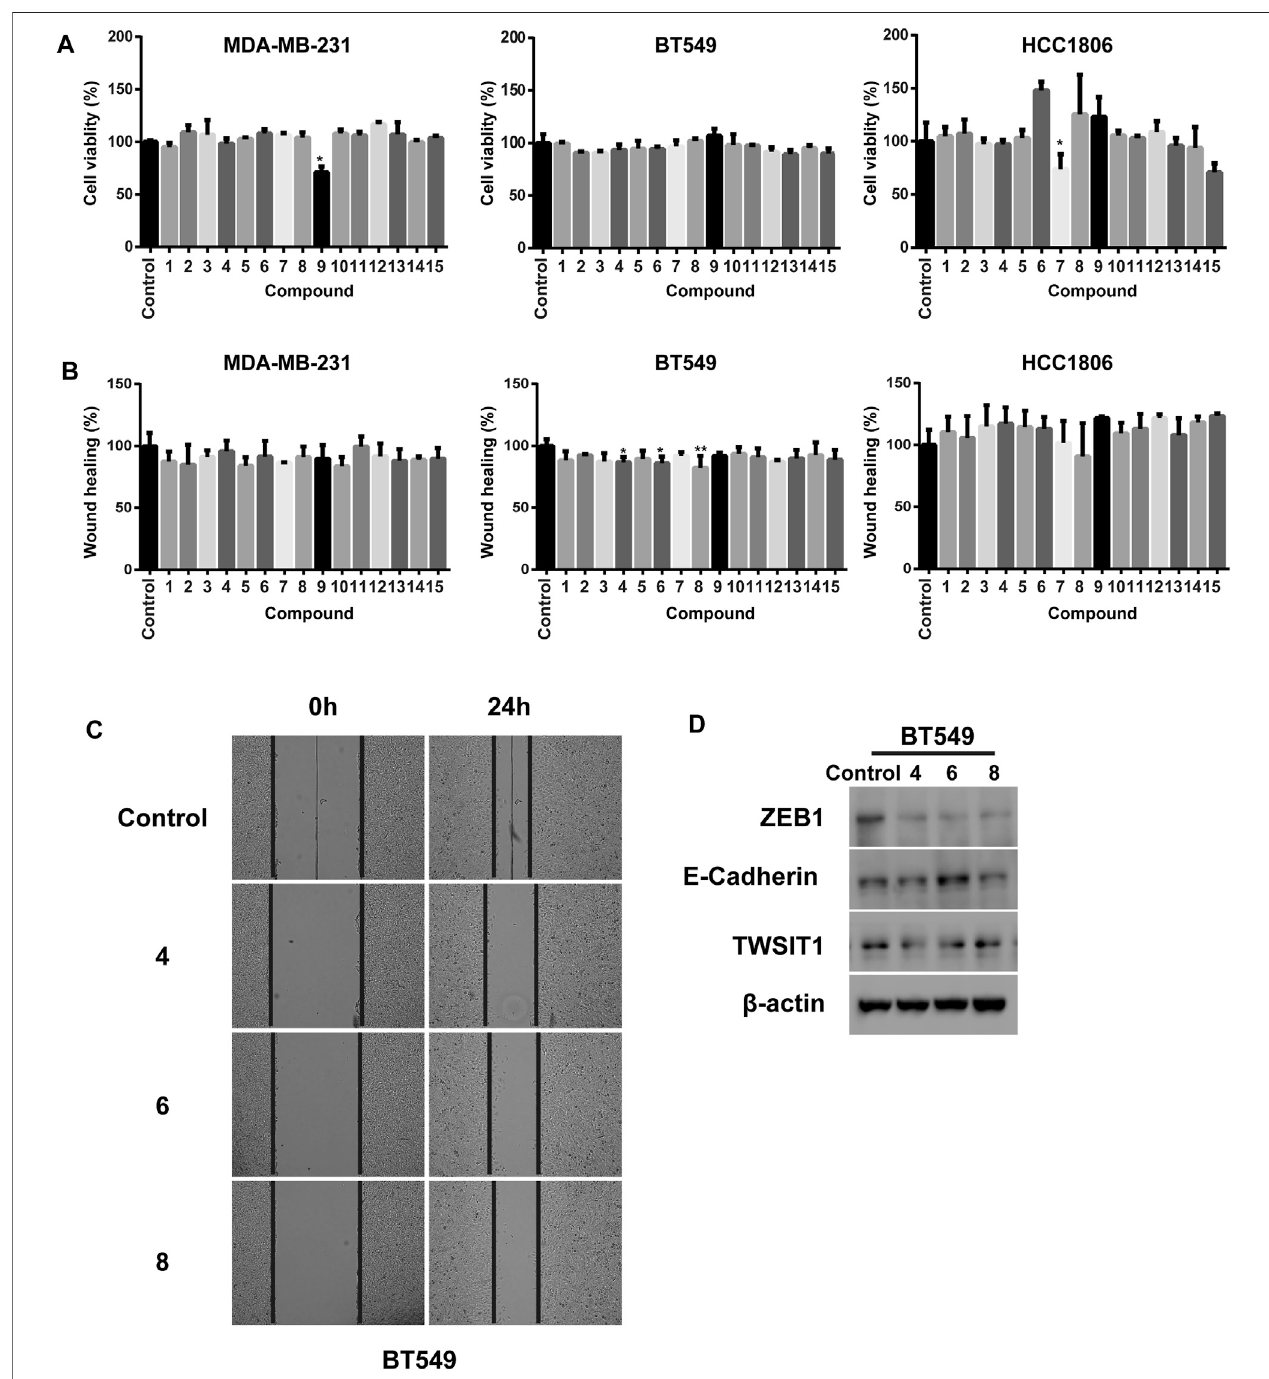
FIGURE 7 | (A) Cell viabilities of MDA-MB-231, BT549 and HCC1806 were analyzed by using CCK8. All compounds concentrations were 20 μ M; (B) Quanti fi cationofthemigratoryabilityofMDA-MB-231,BT549andHCC1806cells.Allcompoundsconcentrationswere20 μ M; (C) Representativeimagesofthewound healing assay in BT549 cells; (D) Compounds 4 , 6 and 8 (40 μ M) treated BT549 celllysates were subjected to immunobloting with the indicated antibodies respectively. The results were represented as mean ± S.D. of biological triplicates. # p < 0.05.